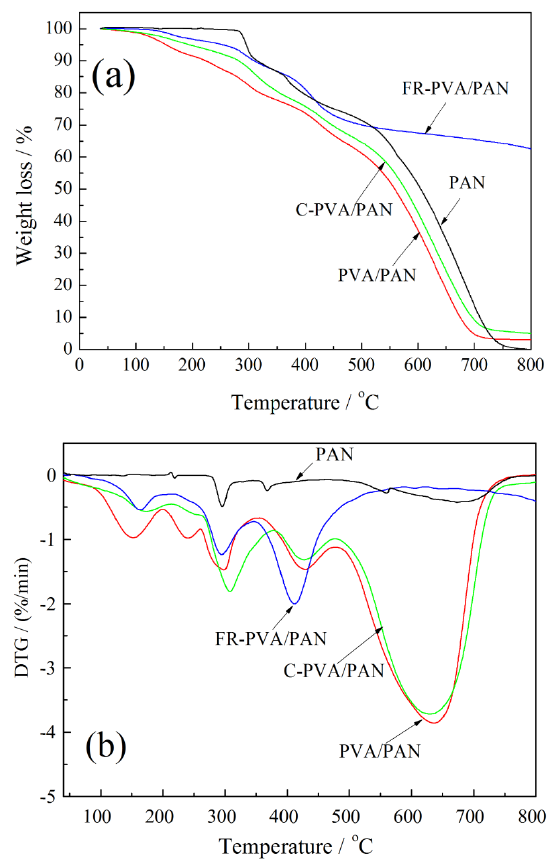
Figure 3. TG and DTG curves of PAN, PVA/PAN, C-PVA/PAN, and FR-PVA/PAN fibers.